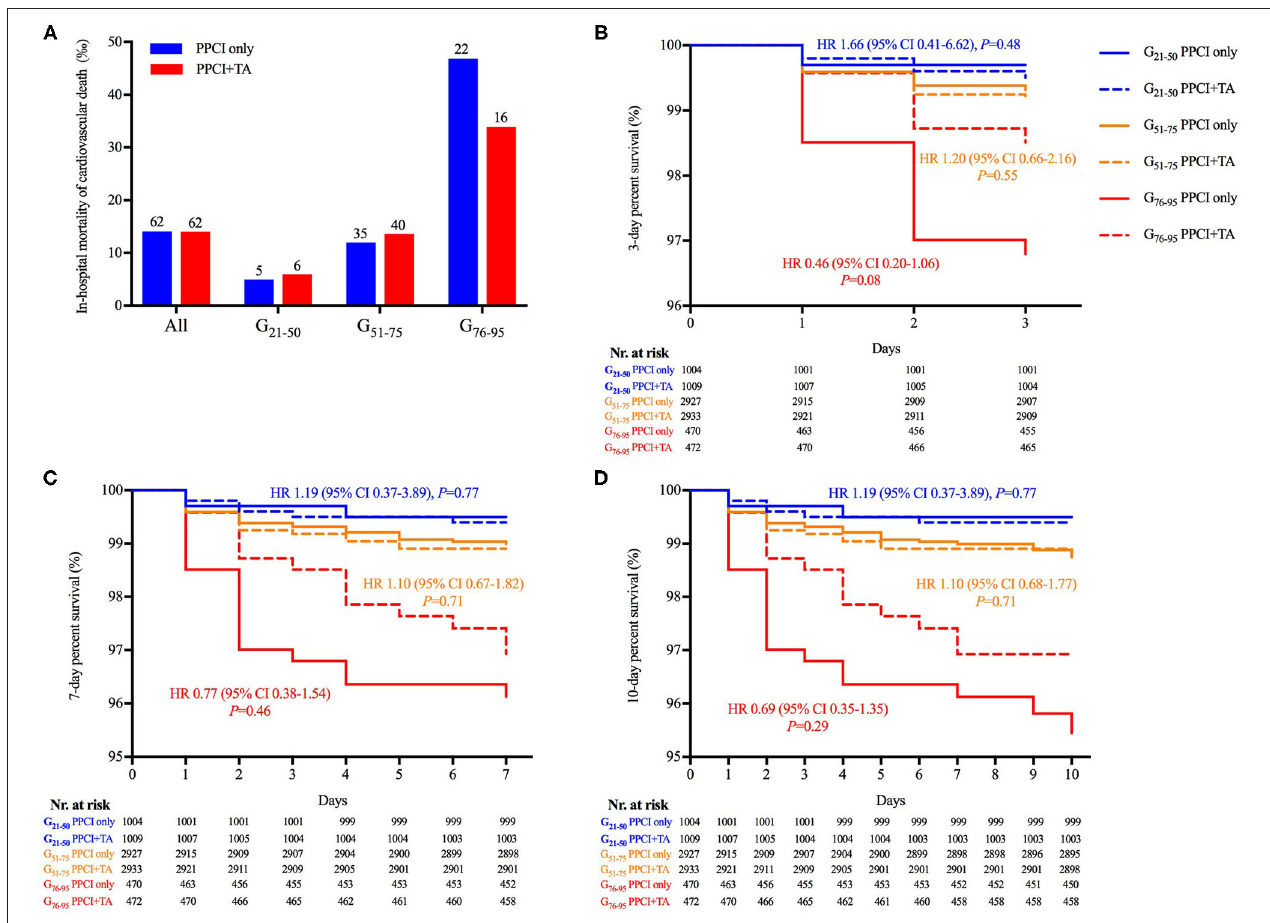
FIGURE 3 | The in-hospital mortality and Kaplan–Meier curves of cardiovascular death. (A) The in-hospital mortality of cardiovascular death was comparable between PPCI-only and thrombus aspiration groups ( P > 0.05). (B–D) Kaplan–Meier curve revealed that the in-hospital occurrence of cardiovascular death was comparable between PPCI-only and thrombus aspiration groups in each age subgroup. However, thrombus aspiration presented a tendency to decrease cardiovascular death at 3 days in the G 76 − 95 subgroup (log-rank P =